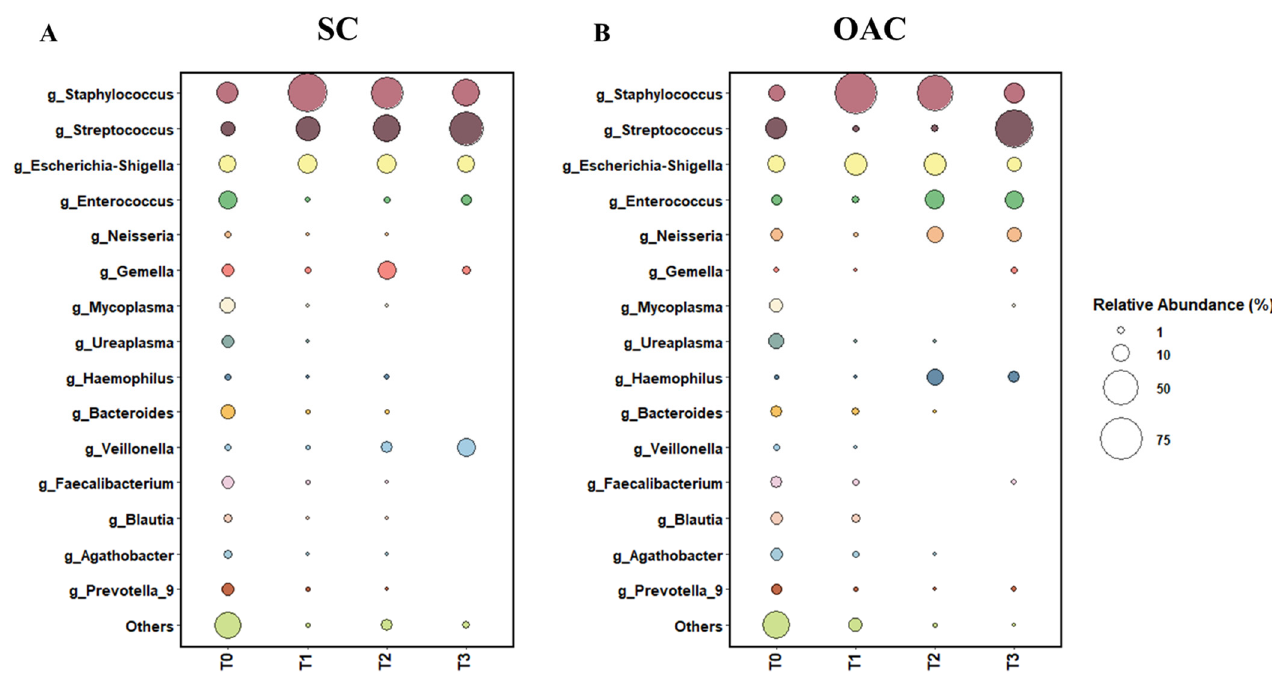
Figure 2. Relative abundance of top 15 genera between SC ( A ) and OAC ( B ) groups over time. Legend: OAC (Oropharyngeal Administration of Colostrum); SC (Standard Care); T0 (first day of life), T1 (7 days after birth), Time 2 (14 days after birth), Time 3 (21 days after birth).